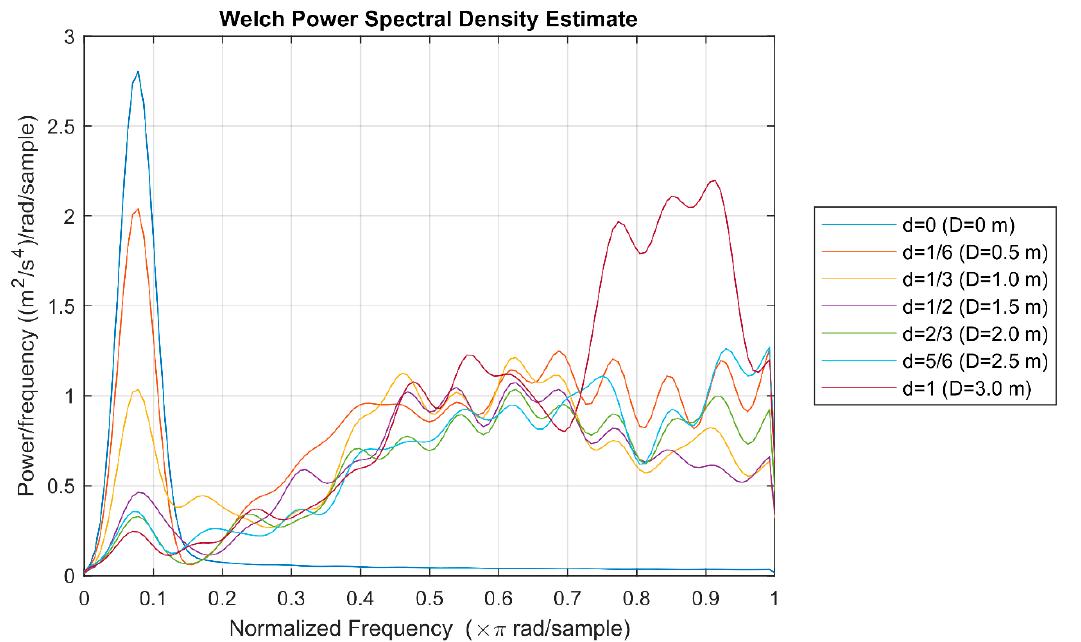
Figure 12. Acceleration spectra of the actuated mass in the first ground profile tested.